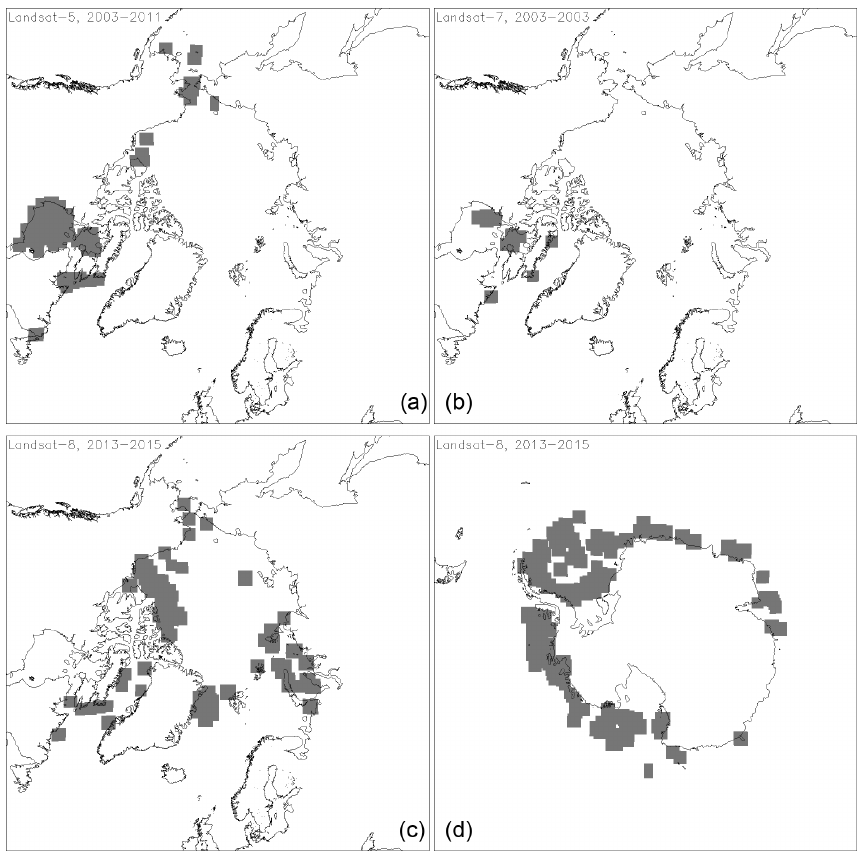
Figure 1. Location of the Landsat scenes used. Panels (a–c) Arctic; panel (d) Antarctic. Note that scenes do overlap. The total number of scenes shown is 134 (a) , 12 (b) , 88 (c) , and 134 (d) . Table 3. Landsat SIC derived using the actual pair of albedo threshold values (“Actual value”) and the four variations of them (see text) averaged for 12 Landsat-8 scenes selected for the Northern Hemisphere (NH) at 25 and 50km grid resolution. The number to the right of the ± denotes 1 standard deviation. All SIC values are in